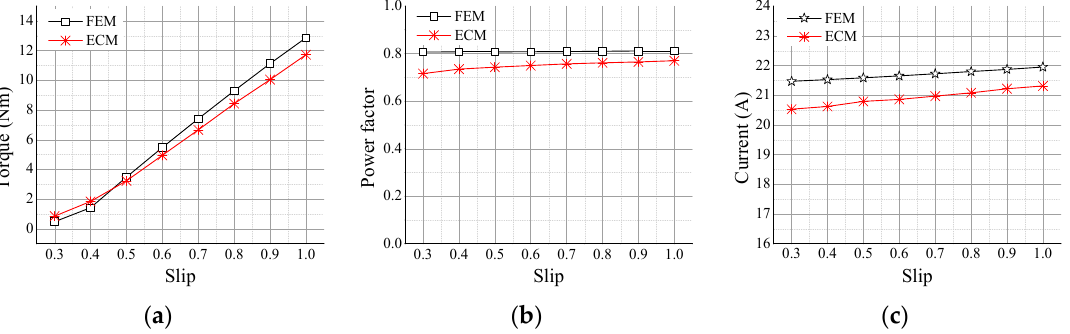
Figure 11. Copper plating model comparative results of ECM and FEMt ( a ) Torque against slip, ( b ) power factor against slip rates, ( c ) stator current against slip.